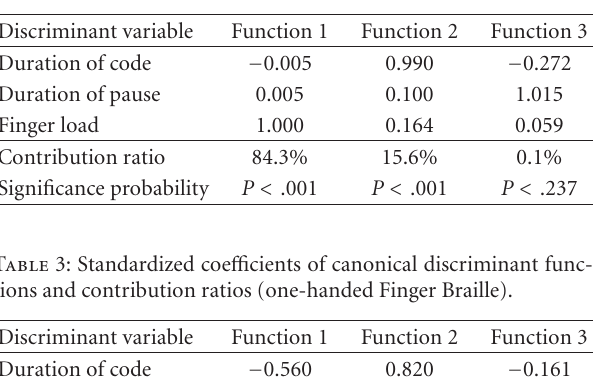
Table 1: Responses of interpreters to questionnaire on expressing emotions.